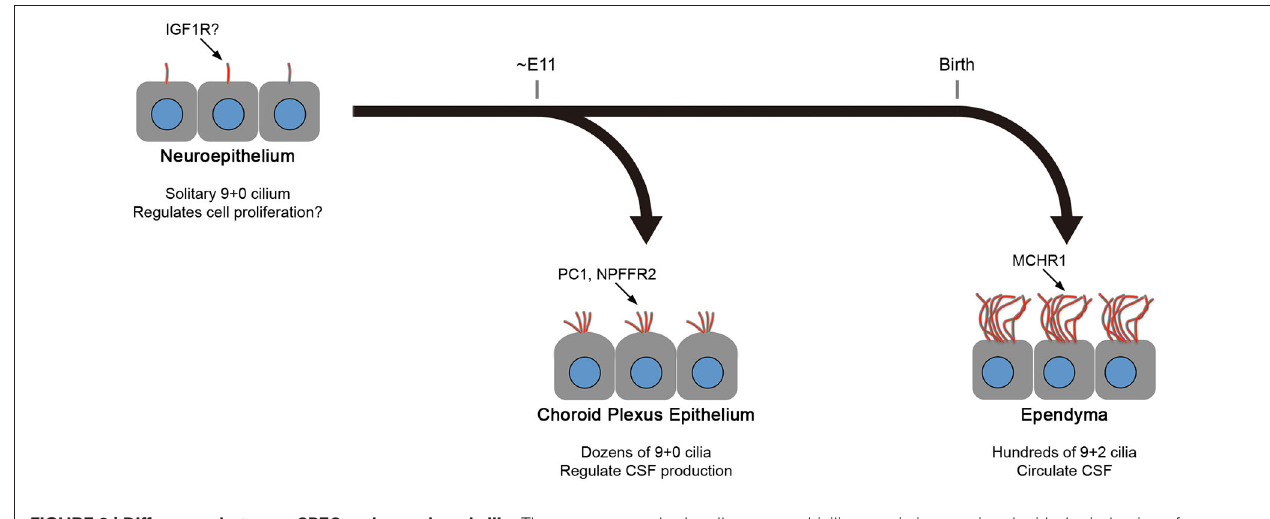
FIGURE 2 | Differences between CPEC and ependymal cilia . The formation of multiple cilia in CPECs occurs shortly after the cells differentiate from the neuroepithelium during organogenesis (about embryonic day 11 in mice). The cilia exhibit transient motility during the perinatal period, which peaks at the day of birth, and eventually become non-motile. However, ependyma undergo multiciliogenesis after birth to establish hundreds of motile cilia in 2 weeks. The beating orientation is aligned at both cellular and tissue levels by planar cell polarity signaling. In